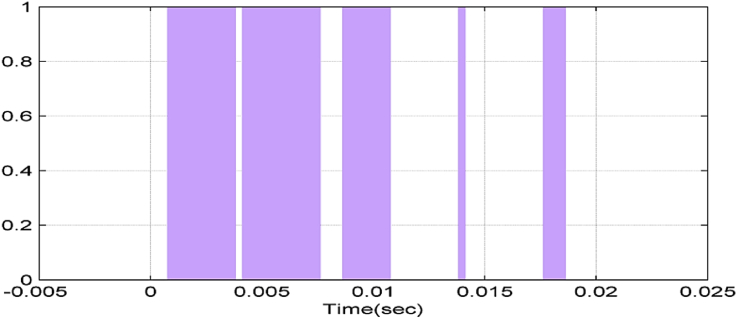
TR5 gate signal.